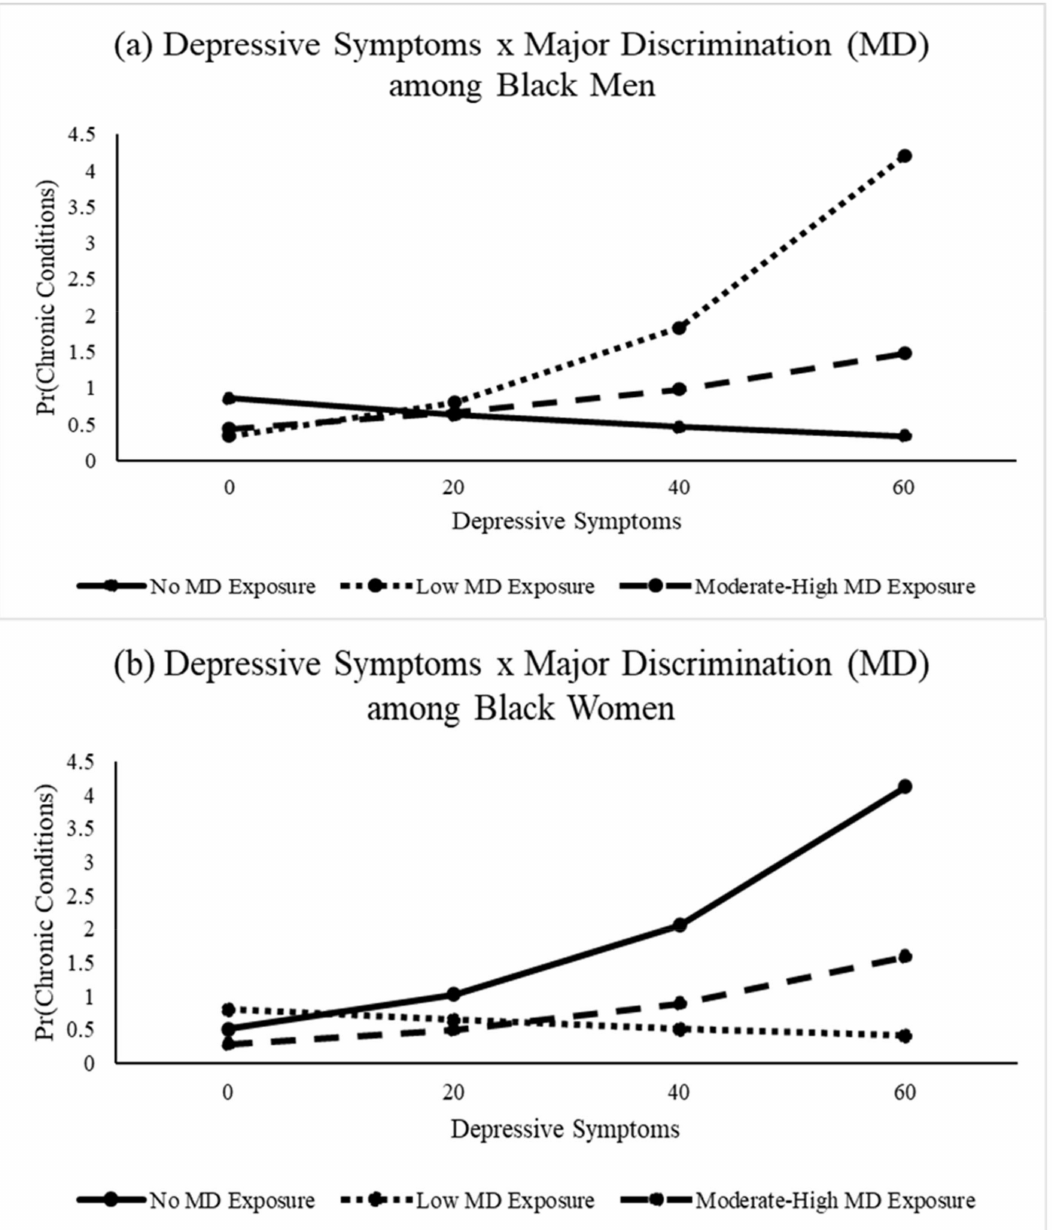
Figure 2. ( a , b ) The Association between Depressive Symptoms and Chronic Conditions is Moderated by Lifetime Major Discrimination and Varies Significantly among Black Menand Women. In ( a ), Black men who had experienced low major discrimination had greater odds of chronic conditions. In ( b ), as depressive symptoms increased for Black women, the odds of chronic conditions increased significantly among women with low and moderate–high discrimination exposure. Data: Nashville Stress and Health Study (2011–2014; N = 627); age, socioeconomic status, and marital status are included as